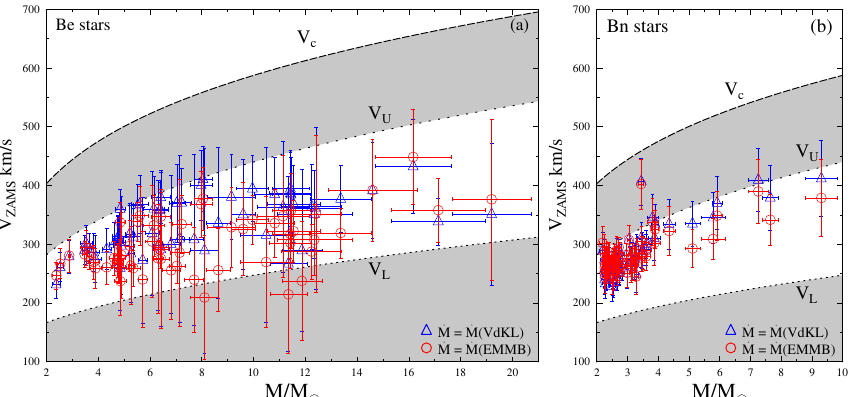
Figure 39. Equatorial rotational velocities V ZAMS of Be (panel a ) and Bn (panel b ) stars deduced using the models of stellar evolution by Ekström et al. [541] with mass-loss rates ˙M(EMMB) (red circles) and ˙M(VdKL) (blue triangles). In the figure, the curve of V c in the ZAMS is shown as a function of the stellar mass and the limiting curves V L and V U that surround the deduced V ZAMS values. Panel ( b ) is reduced to the mass interval M ≤ 10 M (cid:12) concerning the program Bn stars. Adapted from Cochetti et al. [146].